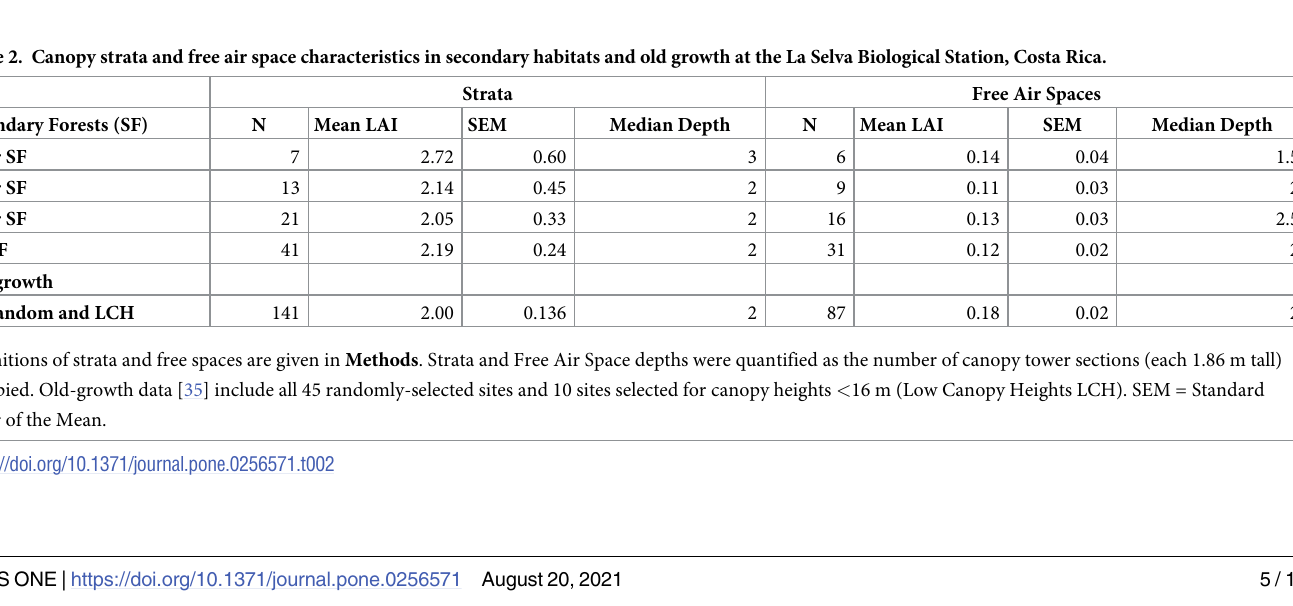
Table 2. Canopy strata and free air space characteristics in secondary habitats and old growth at the La Selva Biological Station, Costa Rica. Strata Free Air Spaces Secondary Forests (SF) N Mean LAI SEM Median Depth